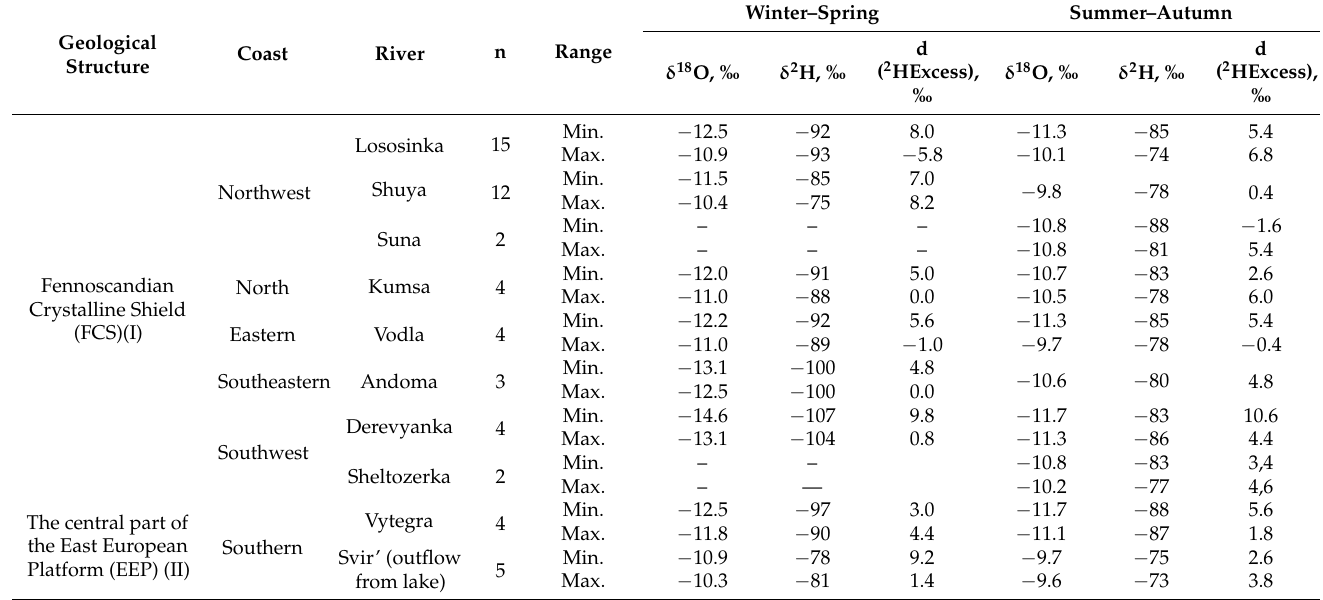
Table 4. Isotopic composition of the river